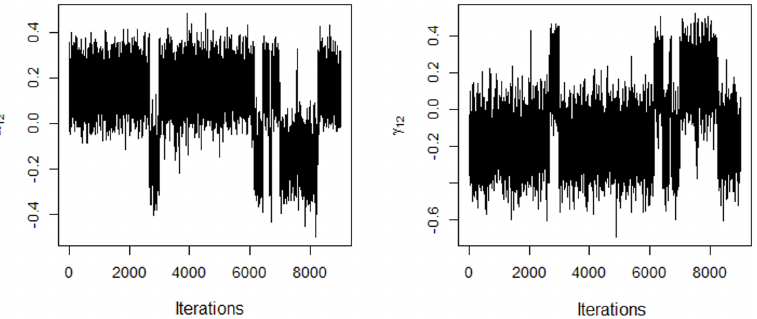
Fig 1. Traces of the chains for the first two coordinates of the genotype and environment singular vectors using the AMMIB model.